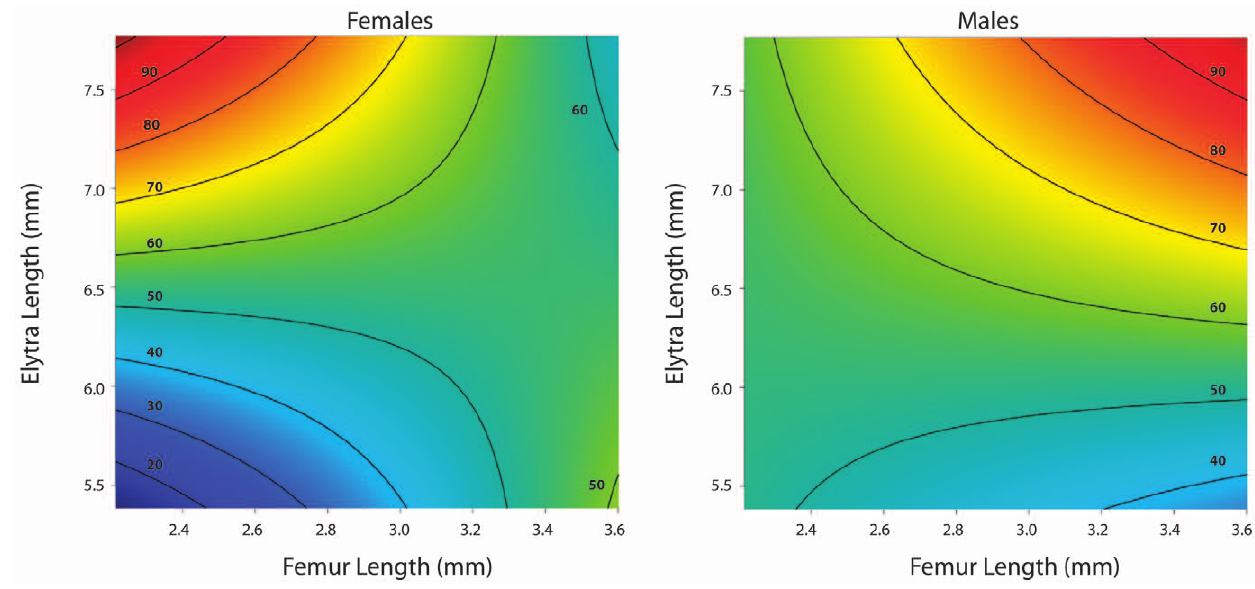
Figure 3. Response surface showing the multivariate relationship of grip strength and morphology for each sex (based on the fully- justified GLM model). Males and females differ in the overall relationship among grip strength, body size, and femur length. Warmer colors (red) signify areas of higher grip strength, while cooler colors (blue) signify areas of weaker grip strength.